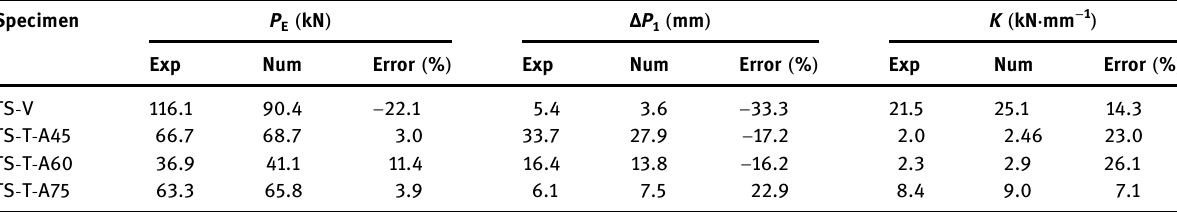
Table 7: Comparison of the elastic ultimate load and initial sti ff ness between the numerical simulations and results